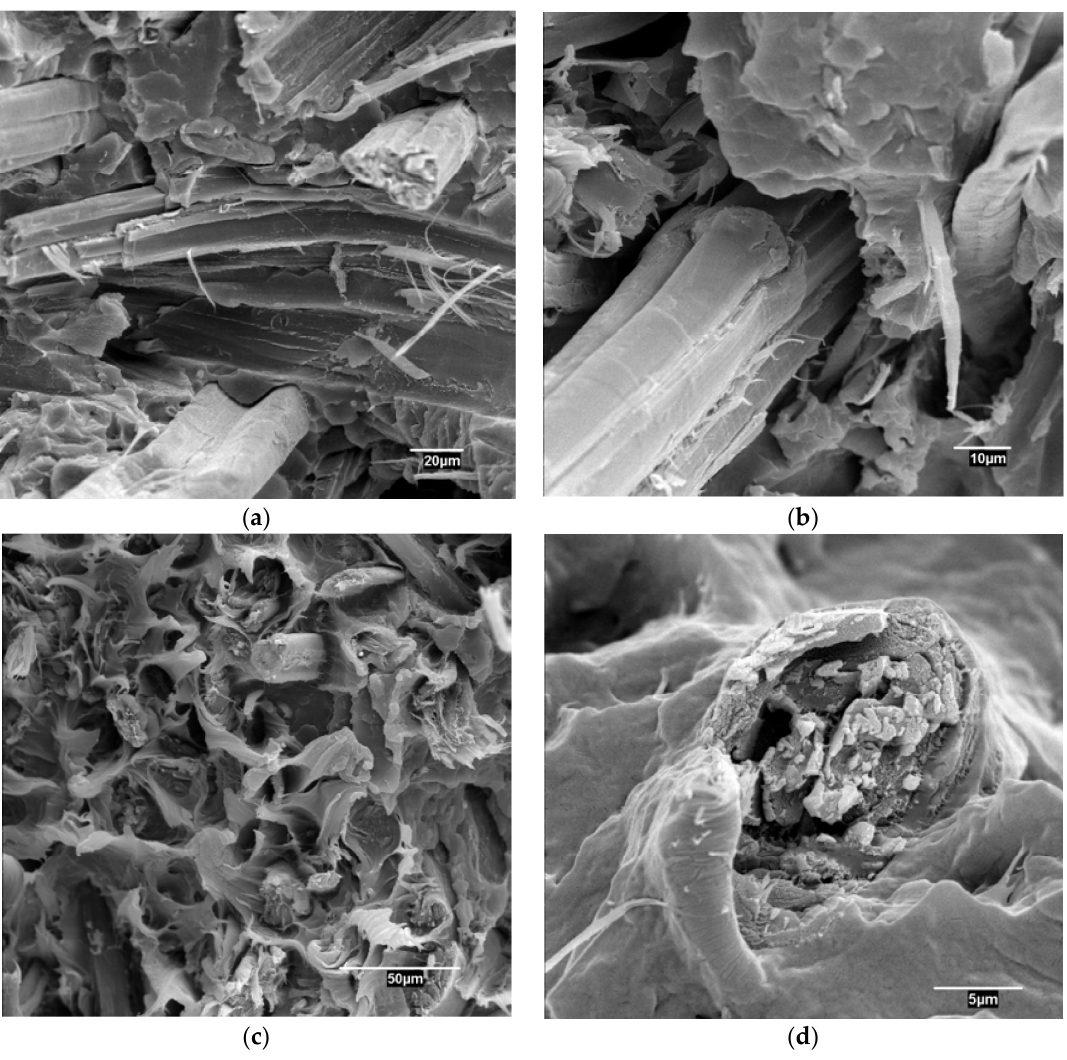
Figure 2. Scanning electron microscope (SEM) micrographs of the sections broken under impact for PP composites reinforced with 40 wt % of HS; ( a , b ): uncoupled composites, ( c , d ): composites adding 4 wt % of MAPP.